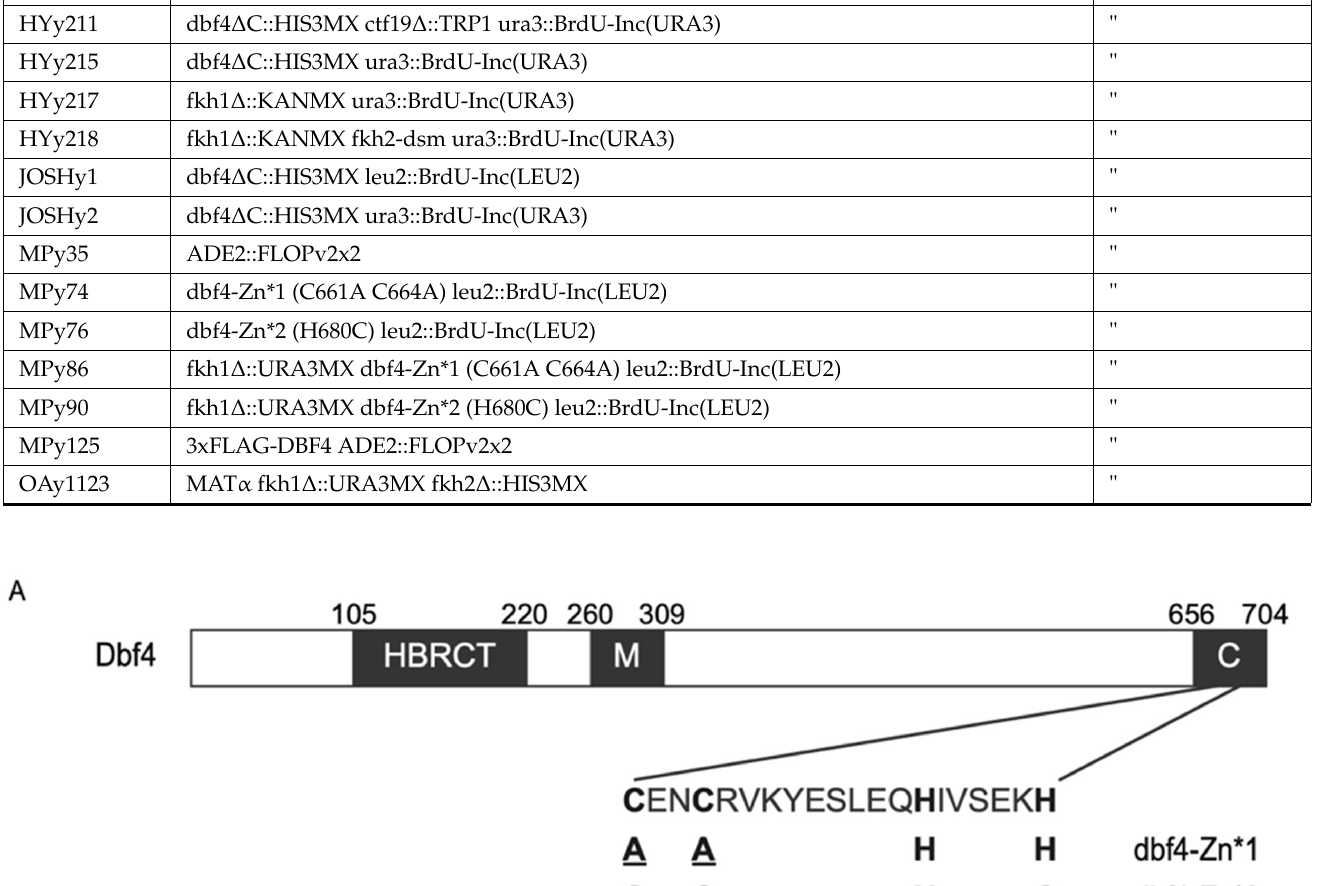
Figure 1. Dbf4 ∆ C is defective in essential Dbf4 function(s). ( A ) Schematic representation of Dbf4 protein domains with sequence detail of the Zn-finger domain; amino acid changes in the Zn* alleles are indicated in lower case, red font. ( B ) Strains CVy63 ( WT ), HYy176 ( dbf4 Δ C), MPy74 ( dbf4-Zn*1 ), MPy76 ( dbf4-Zn*2 ), MPy86 ( dbf4-Zn*1 fkh1 ∆ ), MPy90 ( dbf4-Zn*2 fkh1 ∆ ), HYy210 ( cft19 ∆ ), HYy211 ( cft19 ∆ dbf4 ∆ C ), HYy207 ( cft19 ∆ fkh1 Δ fkh2-dsm ), and HYy218 ( fkh1 Δ fkh2-dsm ) were grown to mid- log phase, diluted, and plated onto rich media, then incubated at the indicated temperatures and imaged after 2-3 days.